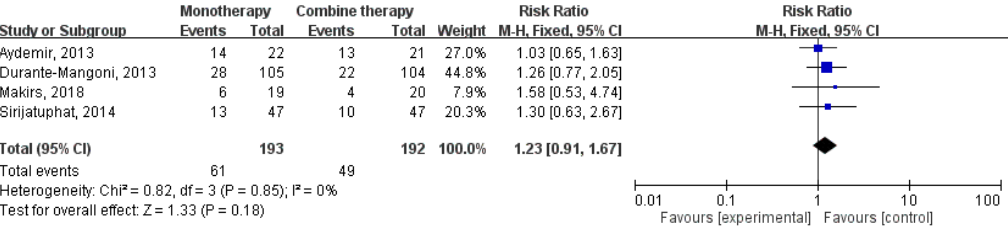
Figure 5. Colistin monotherapy versus colistin-based combination therapy, infection-related mortality. M-H, Mantel-Haenszel.